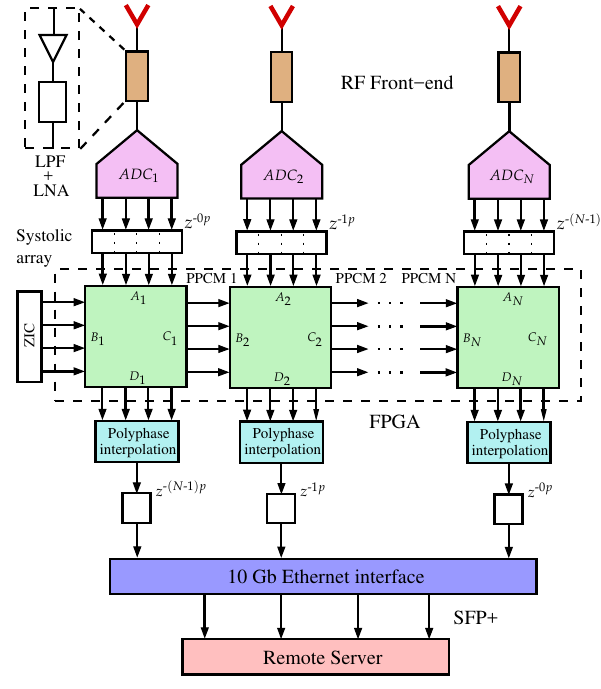
Figure 4. Proposed systolic array architecture of the four phase 2D IIR beam filter with RF front-ends in a ROACH-2 FPGA